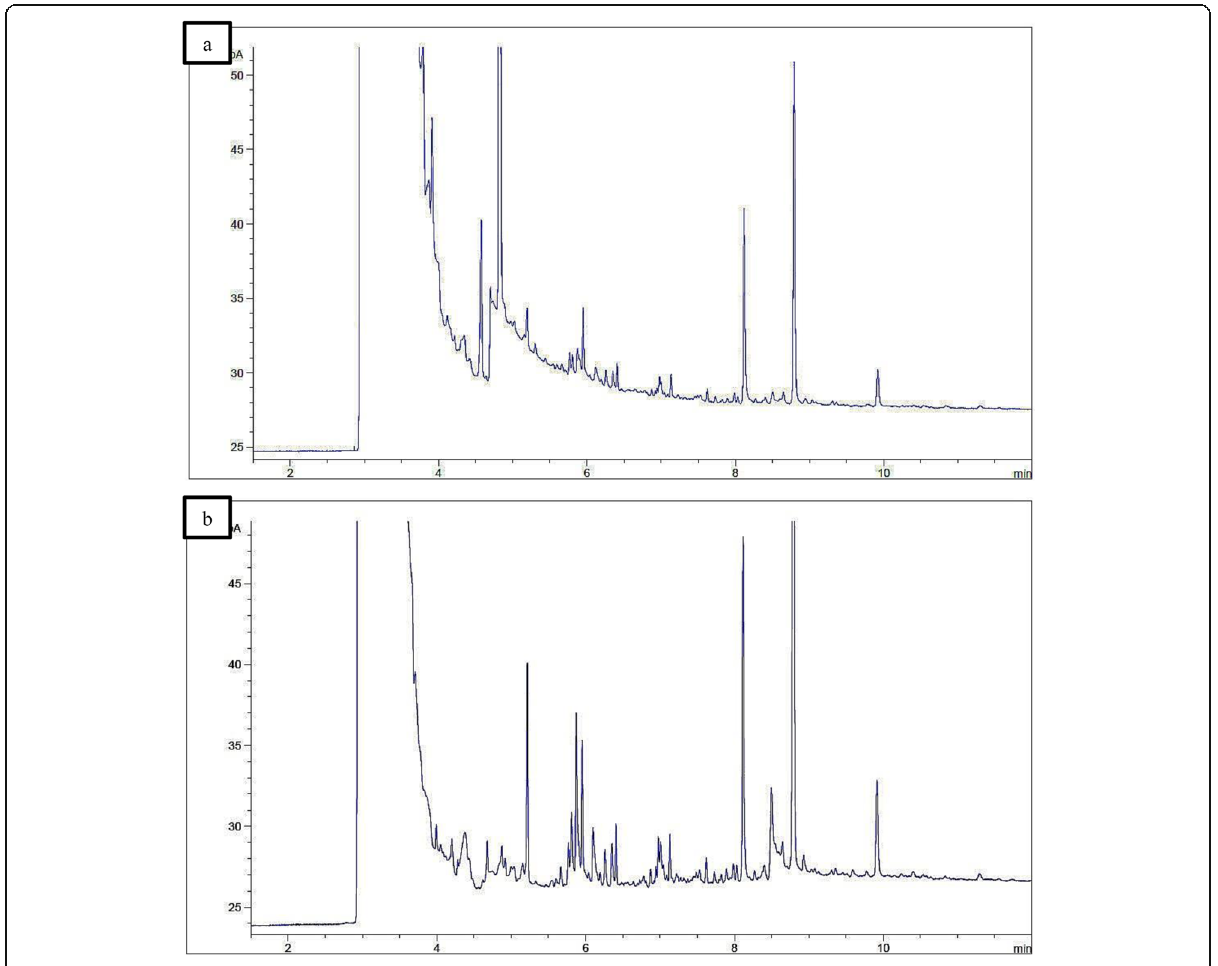
Fig. 3 Chromatogram of shoe odour samples collected by air passive sampling method using ( a ) acetone solvent and ( b ) methanol